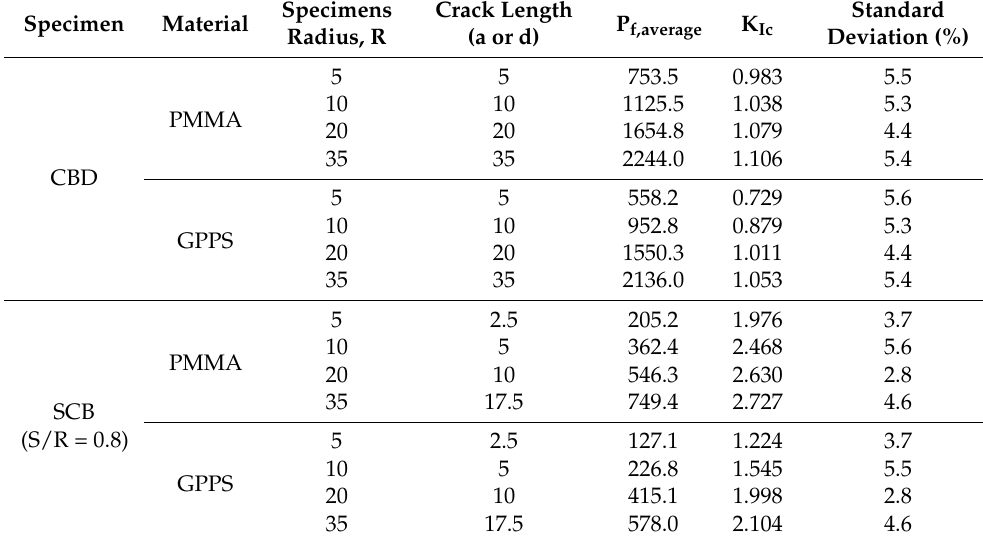
Table 4. K Ic values for PMMA and GPPS obtained from CBD and SCB specimens with different sizes (dimensions in mm, load values in N, K Ic in MPam 1/2 ).